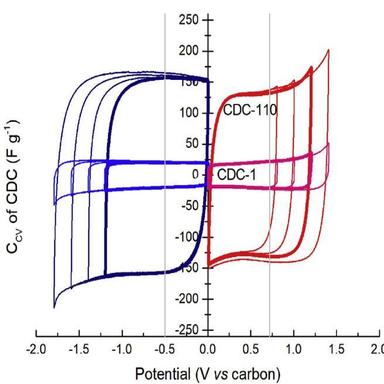
Cyclic voltammetry curves (v ¼ 2 mV s1 ) expressed as gravimetric capacitance for CDC-1 and CDC-110. Fixed potential values for CCV readings are shown by vertical lines at 0.5 and þ 0.7 V. The cycles in bold are used to calculate the capacitance. (A colour version of this figure can be viewed online.)